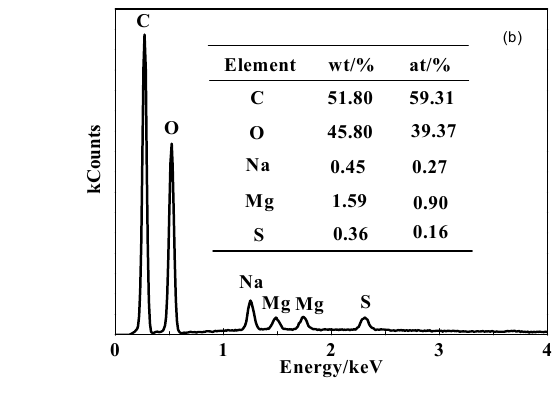
Figure 6. EDS images of ( a ) DG and ( b ) MDG.